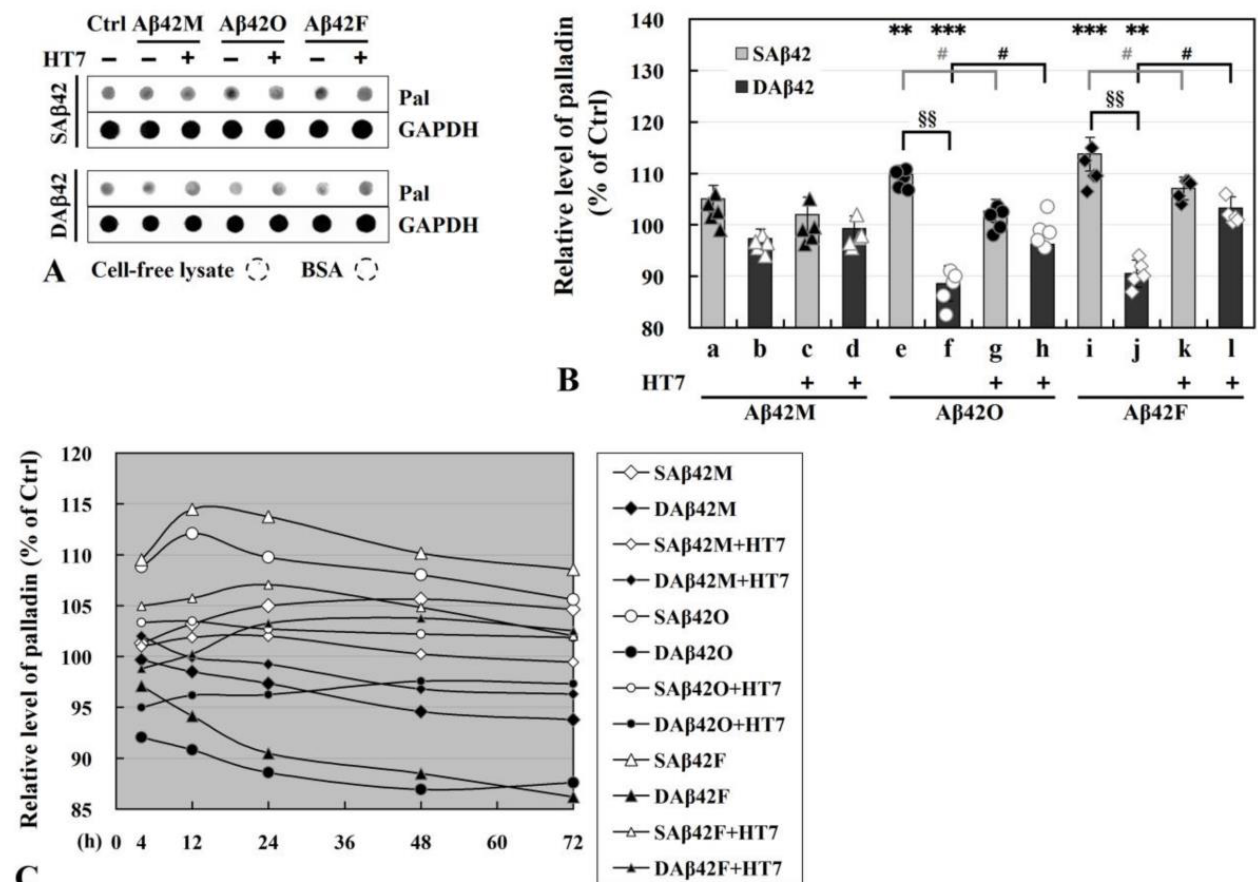
Figure 4. Analysis of palladin level in differentiated SH-SY5Y cells in the presence of extracellular A β 42 or its aggregates with or without anti-oligomeric A β 42 antibody HT7 (or HT6) for 24 h. ( A ) Representative dot images for the analysis of palladin levels in the lysate supernatants of differentiated SH-SY5Y cells by dot blot assay after 24 h of culture. Approximately 10 µ g of protein was loaded per dot. Pal, palladin; Ctrl, control; BSA, bovine serum albumin. The percentage of palladin level in the control group in ( B , C ) was considered as 100%. ( B ) Percentages of palladin levels calculated by quantitative grayscale analysis of the corresponding dots in ( A ). ** p < 0.01 or *** p < 0.001, between A β 42-treated and the control groups. §§ p < 0.01, between SA β 42O/SA β 42F and DA β 42O/DA β 42F subgroups. # p < 0.05, between A β 42O/A β 42F groups with and without HT7 (or HT6) antibody. ( C ) Time-courses of the percentages of palladin levels in all groups from 4 to 72 h. The legend on the right indicates the name of each group. The error values of all experimental points were within 5%, not shown on the curves.